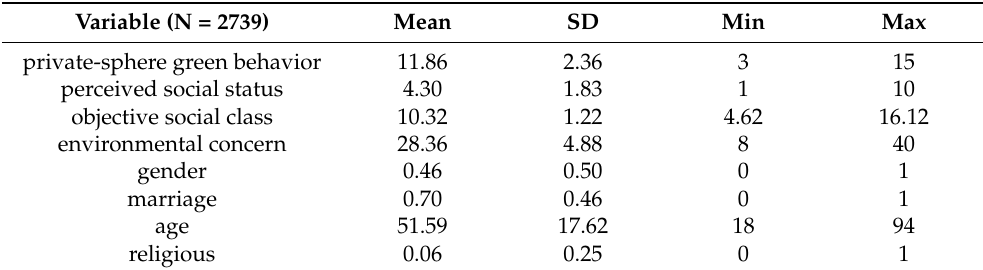
Table 1. Descriptive statistics of all studied